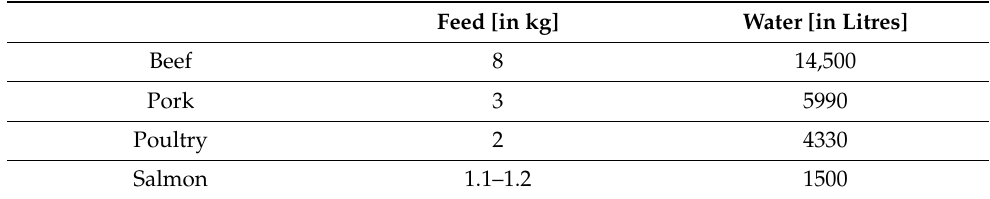
Table 2. Amount of feed and water necessary to produce 1 kg of